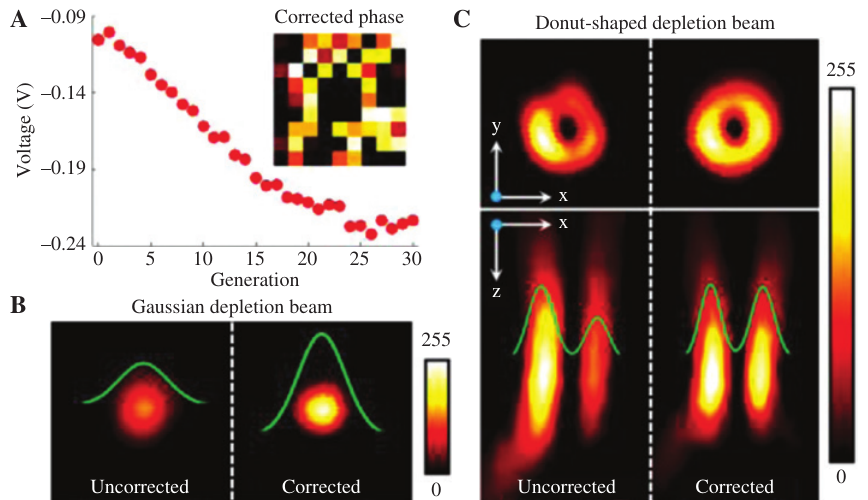
Figure 3: The correction of system-induced aberration by genetic algorithm. (A) The voltage change during the correction and the final corrected phase. (B, C) The comparison of scattering images of a gold nanoparticle between before and after aberration correction illuminated by Gaussian and donut-shaped depletion beam, respectively. Notes: green profiles in (B) and (C) are respective fit curves of normalized